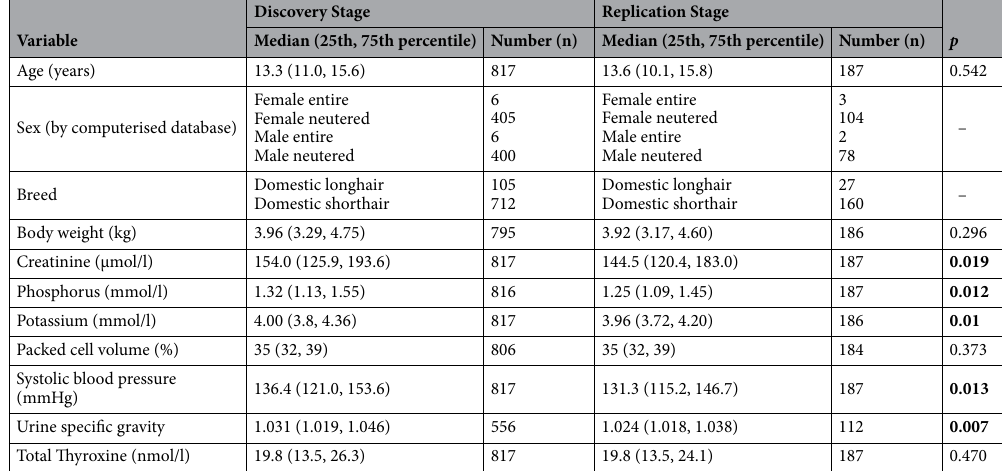
Table 2. Baseline signalment and clinicopathological data for cats included in the quantitative association with systolic blood pressure from the discovery stage with comparison to replication analysis. P ; statistical significance comparing baseline parameters for discovery and replication stage for cats included in quantitative association analysis with systolic blood pressure. Replication data are found in Table 1. ( P -values in bold if P <